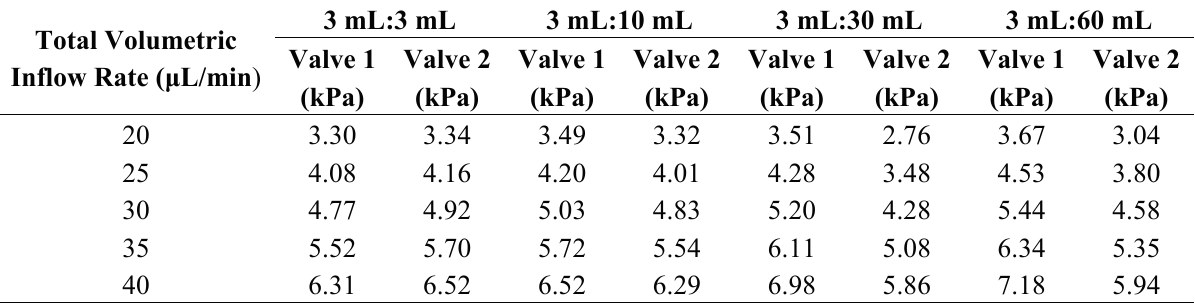
Table 2. Larger maximum pressures observed in valve receiving smaller inflow